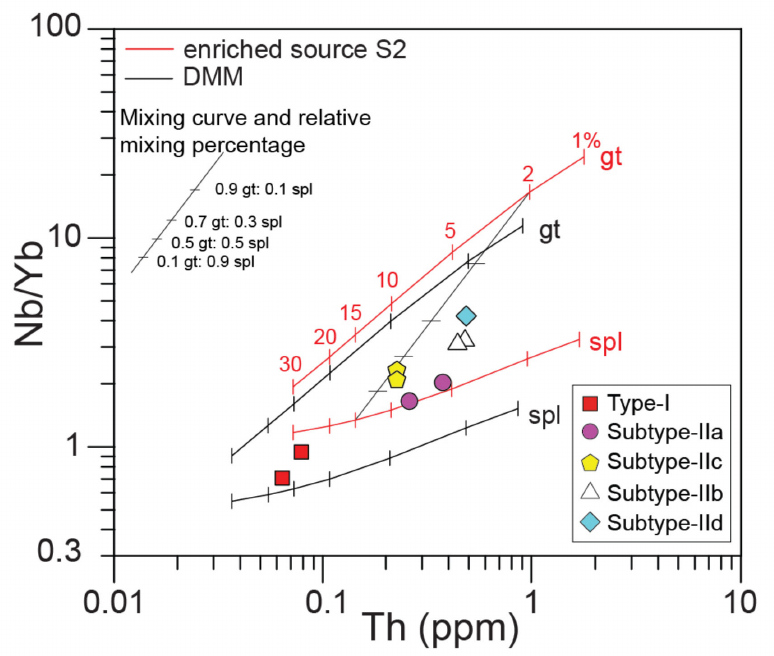
Figure 15. Melt curve models based on Th vs. Nb / Yb and compositions of the relatively more primitive basalts for each rock type and subtype. Melt curves are calculated using non-modal, batch partial melting of DMM [96] and a theoretically enriched mantle source (S2). Ticks on all melting curves indicate the same percentages of partial melting as shown for the melting curve of source S2 in the garnet-facies. The thin black line represents the mixing line of various melt fractions from garnet- and spinel-facies mantle. Input parameters for the REE models (source modes, melting proportions, and partition coe ffi cients), as well as compositions of the mantle sources, are shown in Supplementary Table